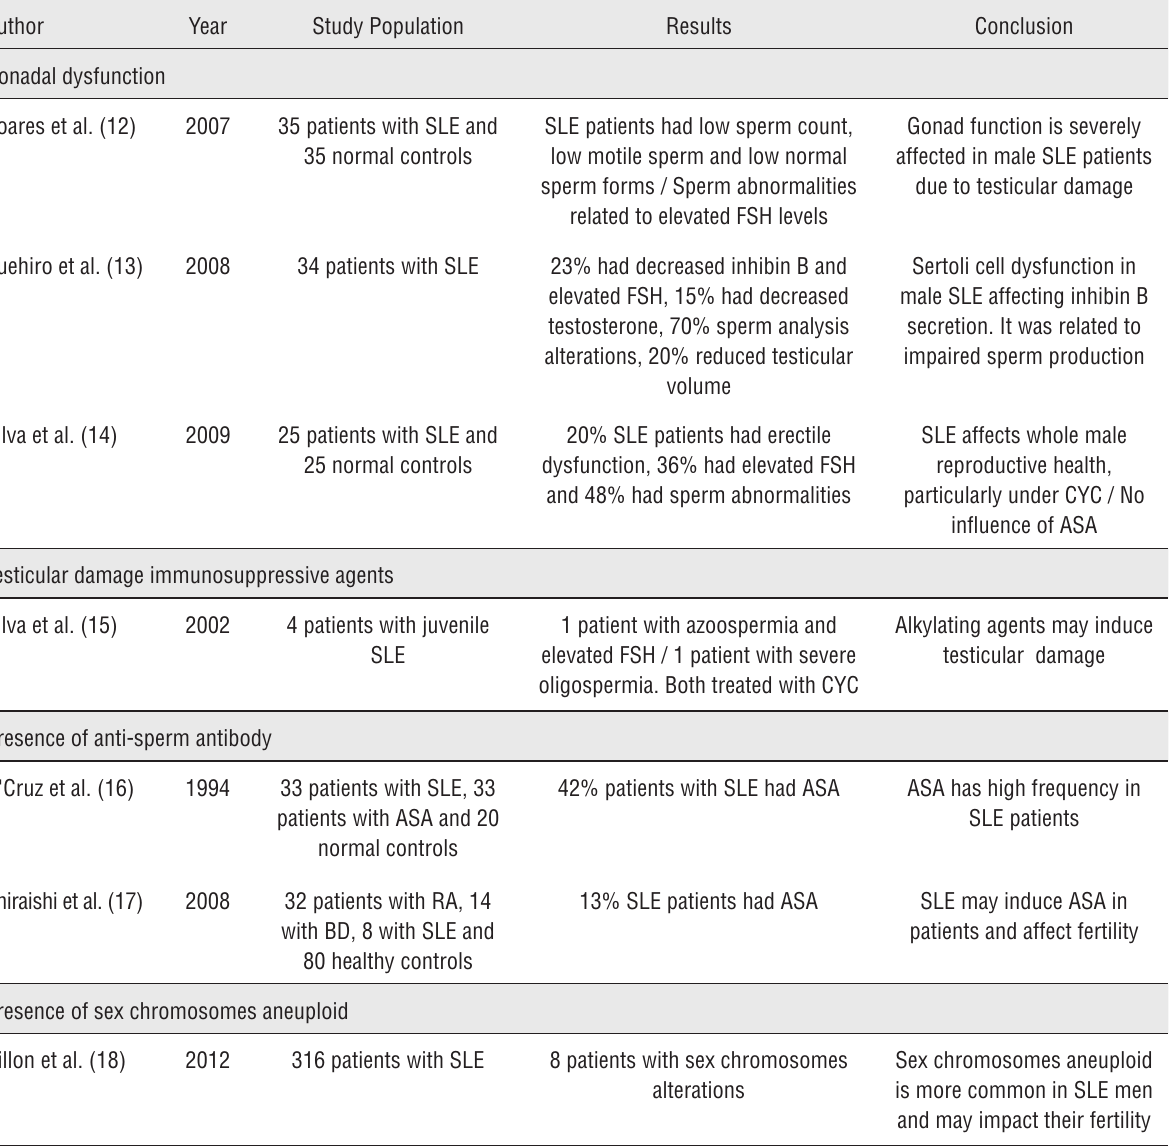
Table 1 - systematic lupus erythematosus and male fertility according to gonadal dysfunction, immunosuppressive agents, anti-sperm antibody and sex chromosomes